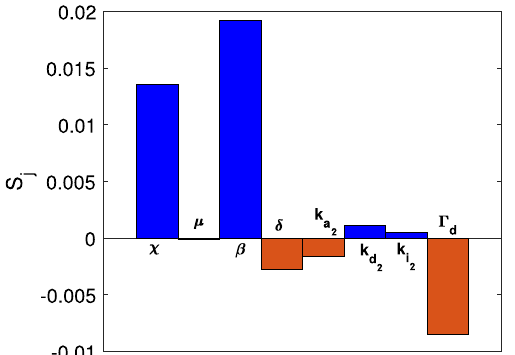
Figure 2. Bar diagram representing the sensitive index of eight parameters used in the model